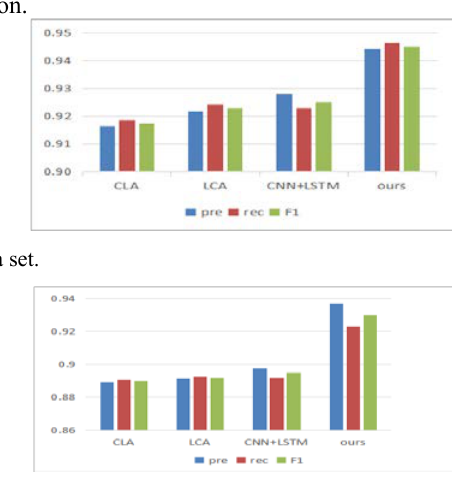
Fig. 6. Comparison of IMDB experimental results.